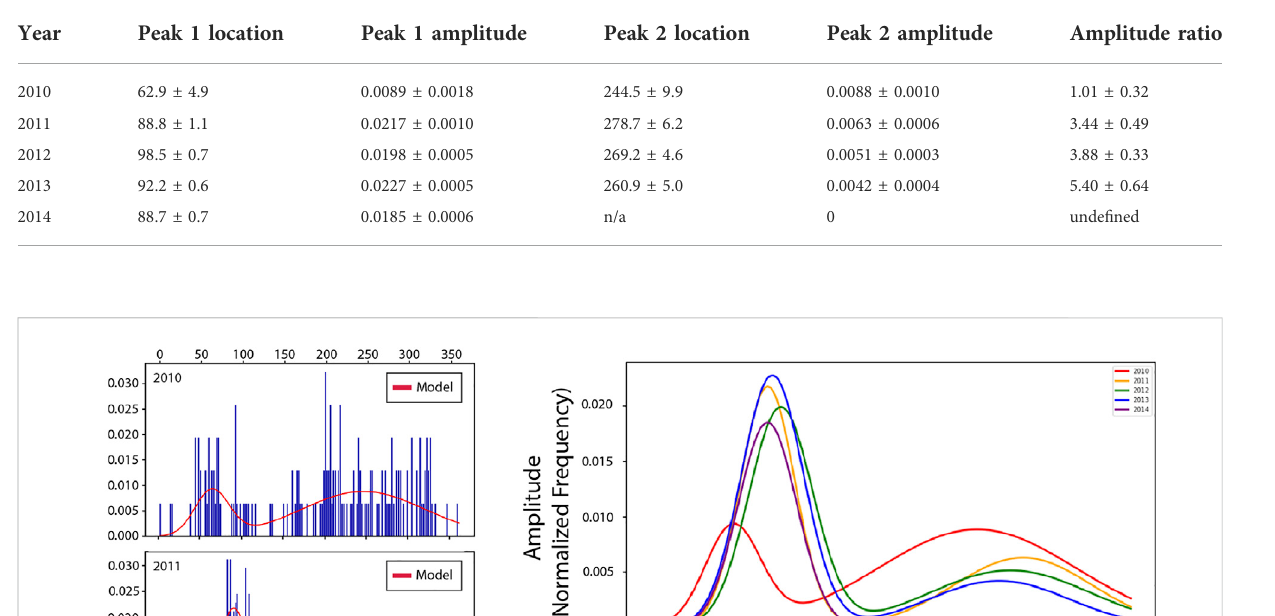
TABLE 2 Bimodal gaussian model parameter estimations.